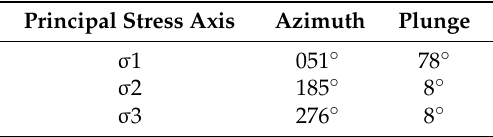
Table 1. Calculated principal stress directions from the stress inversion on all modelled data (inversion A).